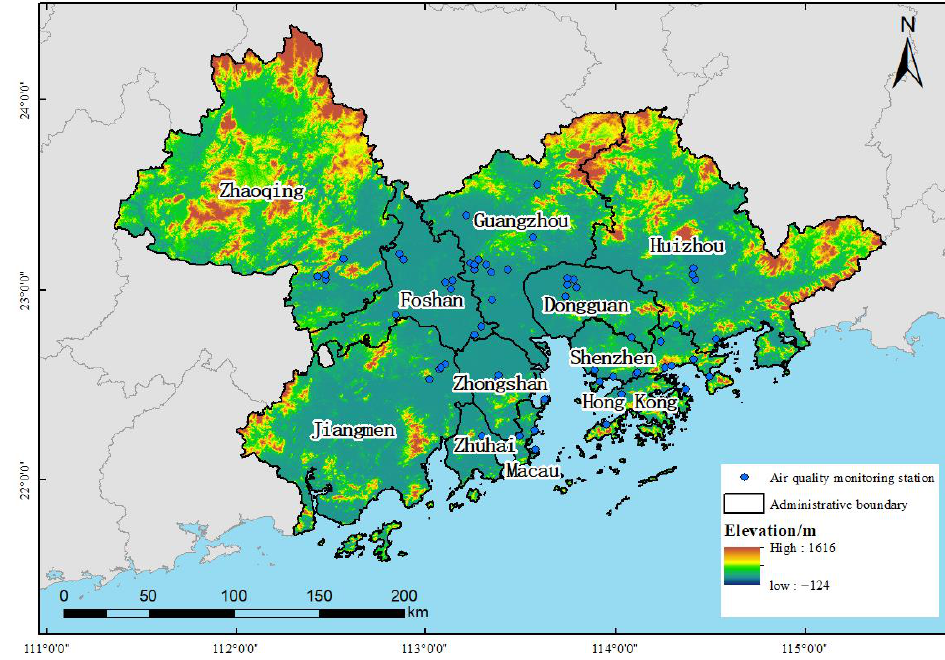
Figure 1. Spatial distribution of the monitoring sites in the study area.